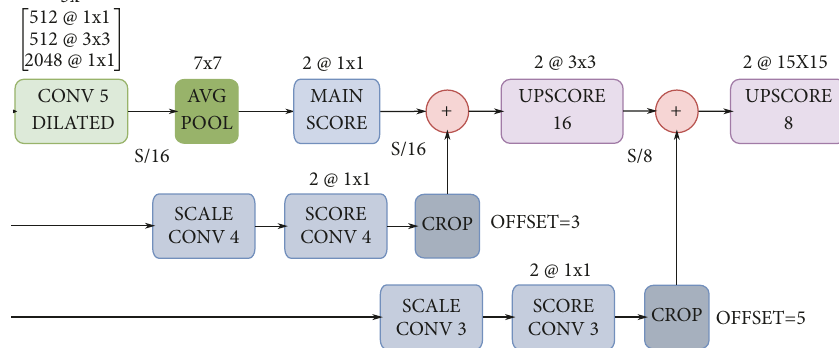
Figure 3: Detail of the scoring stage with dilated convolution in CONV 5. It removes the necessity of using the UPSCORE 32 layer.